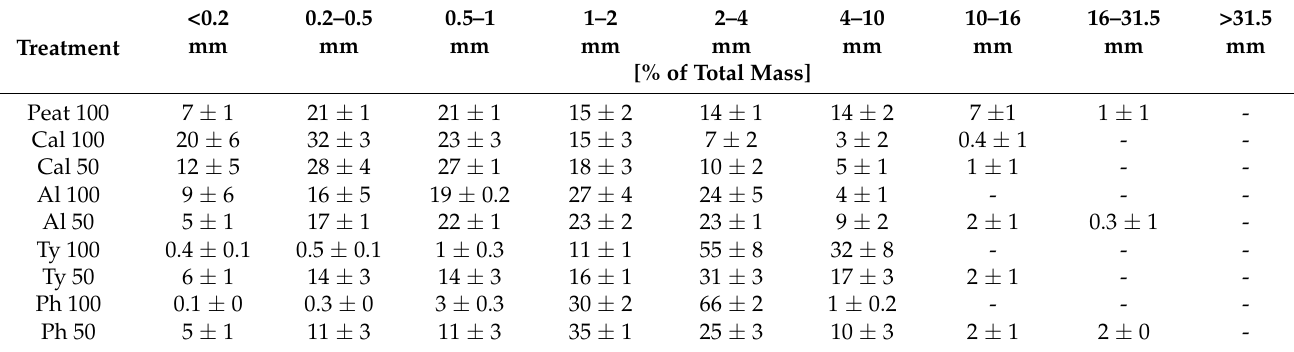
Table A2. Particle size distribution of the different treatments in stage 1 determined according to DIN EN 11540 [23] (n = 3). Explanation of treatment names see Table 1.